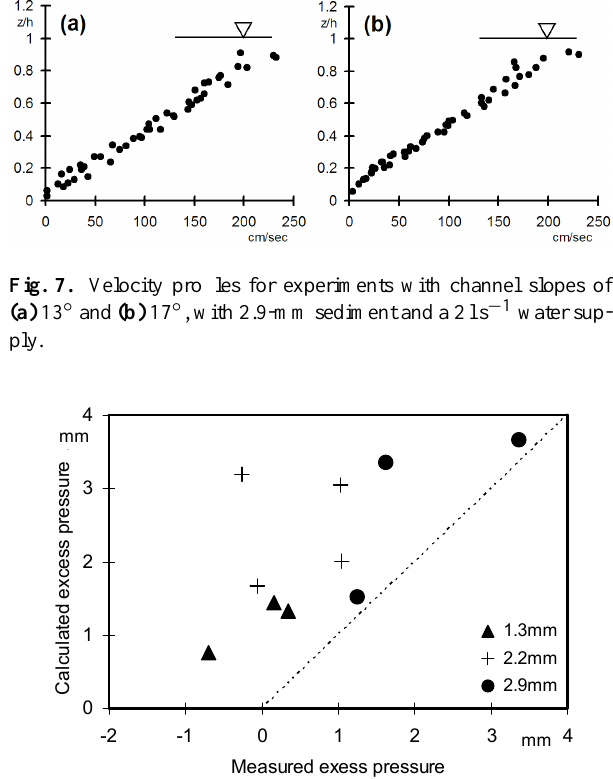
Fig. 8. Relationship between the measured and calculated values of the excess interstitial water pressure over hydrostatic pressure. The dotted line indicates the agreement between theoretical and experimental values.